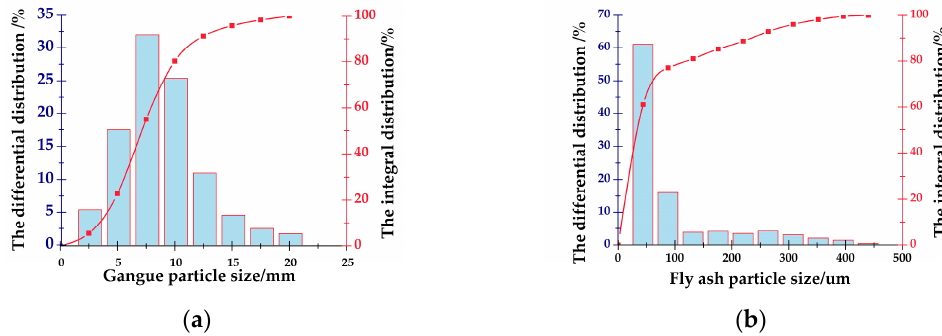
Figure 3. Particle size distribution. ( a ) Gangue particle size. ( b ) Fly ash particle size.